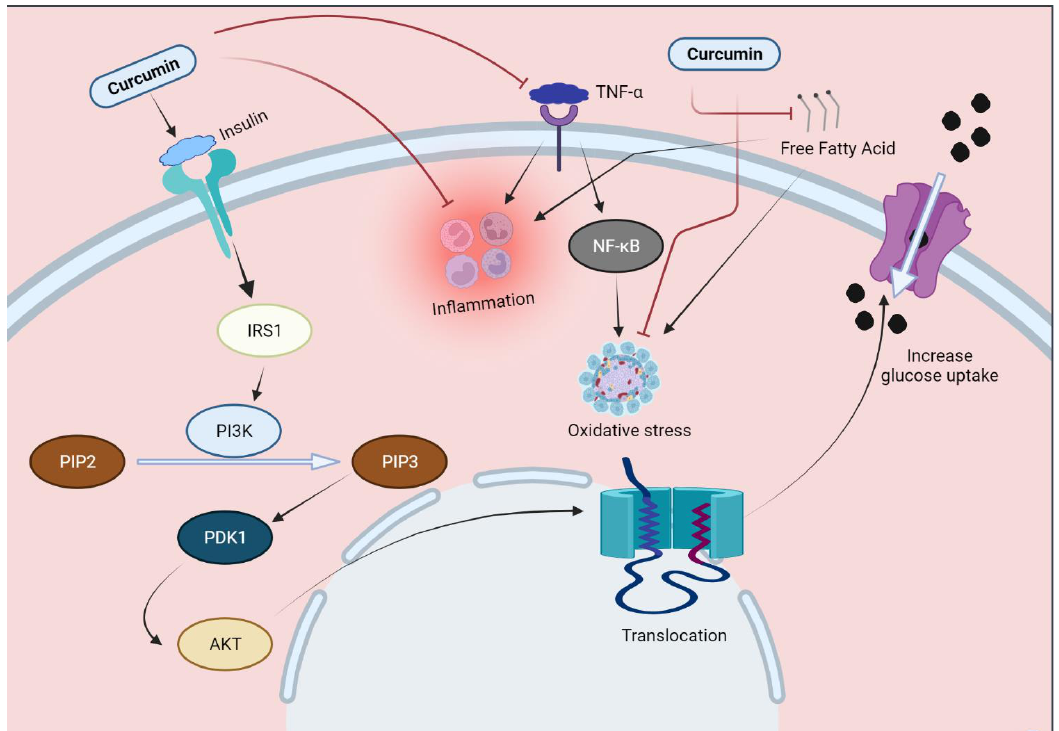
Figure 3. Curcumin effect on inflammatory mediators, and its cellular effects. Activation of tissue necrosis factor leads to induction of oxidative stress and inflammation, while excessive fatty acid leads to induction of inflammation. Curcumin